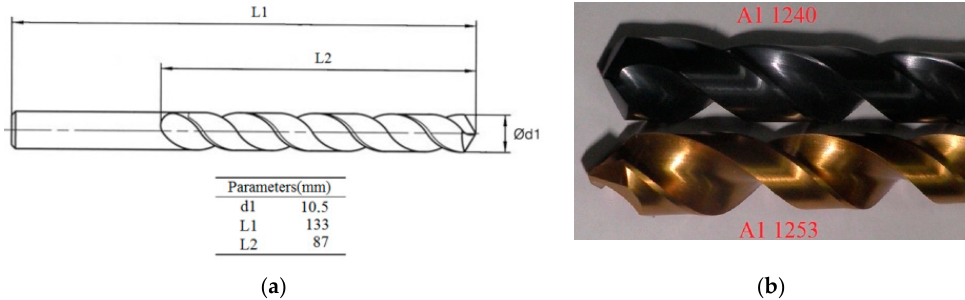
Figure 3. ( a ) Drill tool geometry and dimensions; ( b ) Materials and uses of the tools: A11240 is